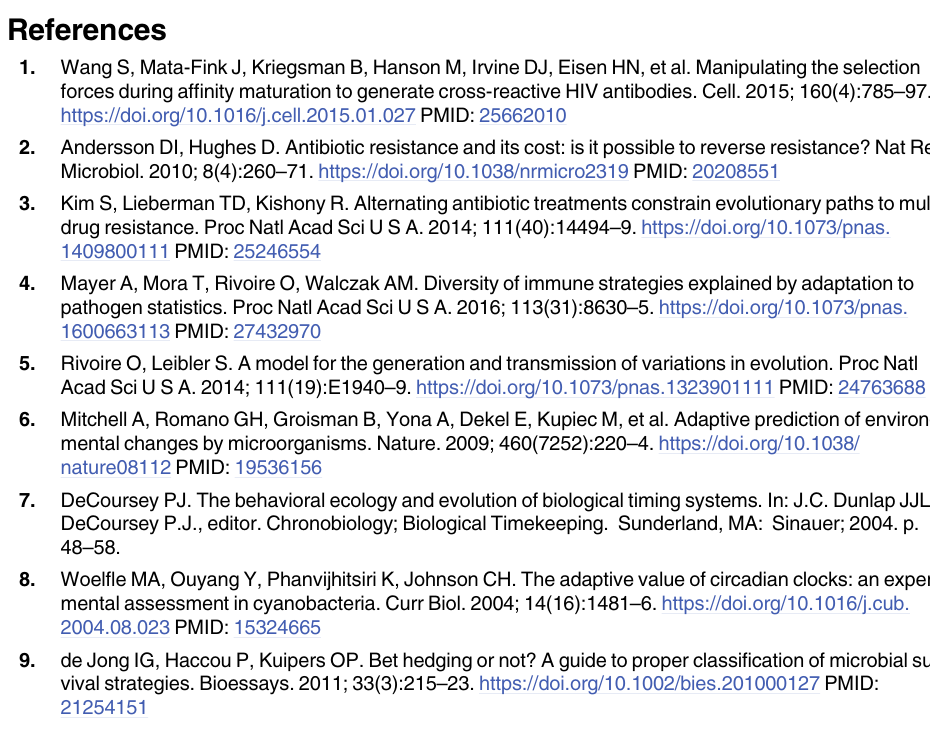
S25 Fig. Aikike criterion and thread mean fitness: Comparison of fitness between remea- surement and Maximum Likelihood estimation from lineage tracking.